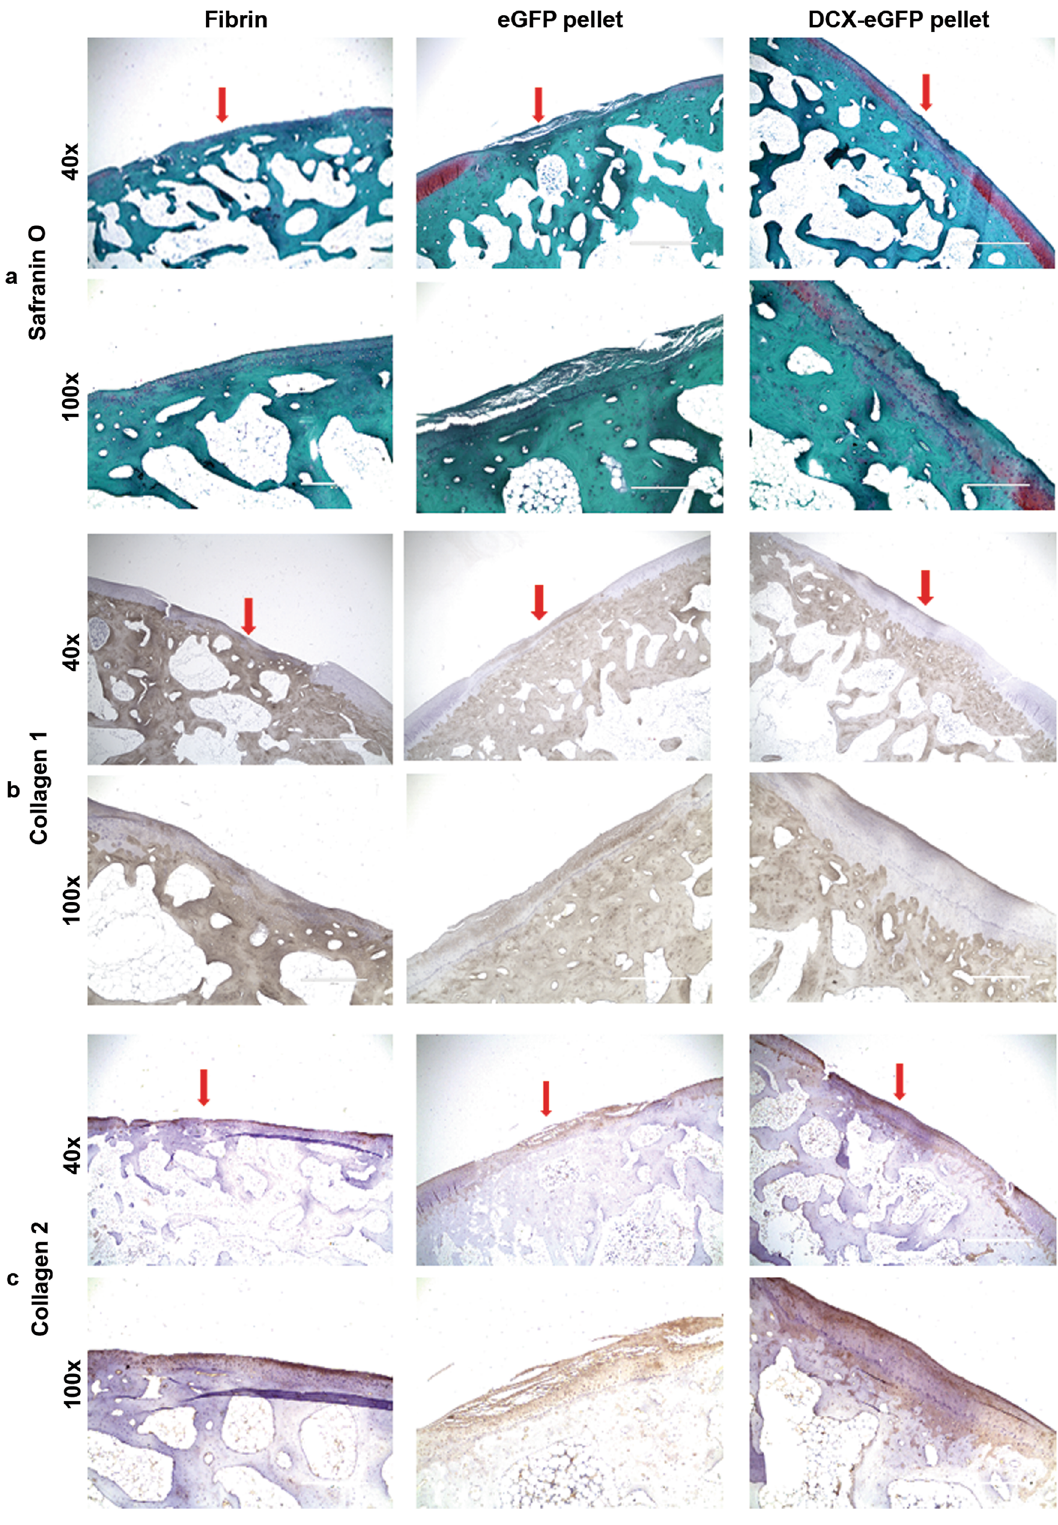
Fig. 5 Representative photomicrographs of rabbit cartilage tissue sections at 24 months after surgery. a Safranin O staining. b Immunohistochemical staining of collagen 1. c Immunohistochemical staining of collagen 2. Arrows, the repaired cartilage defects. ×40 magni fi cation, scale bars = 1000 µm. ×100 magni fi cation, scale bars = 400